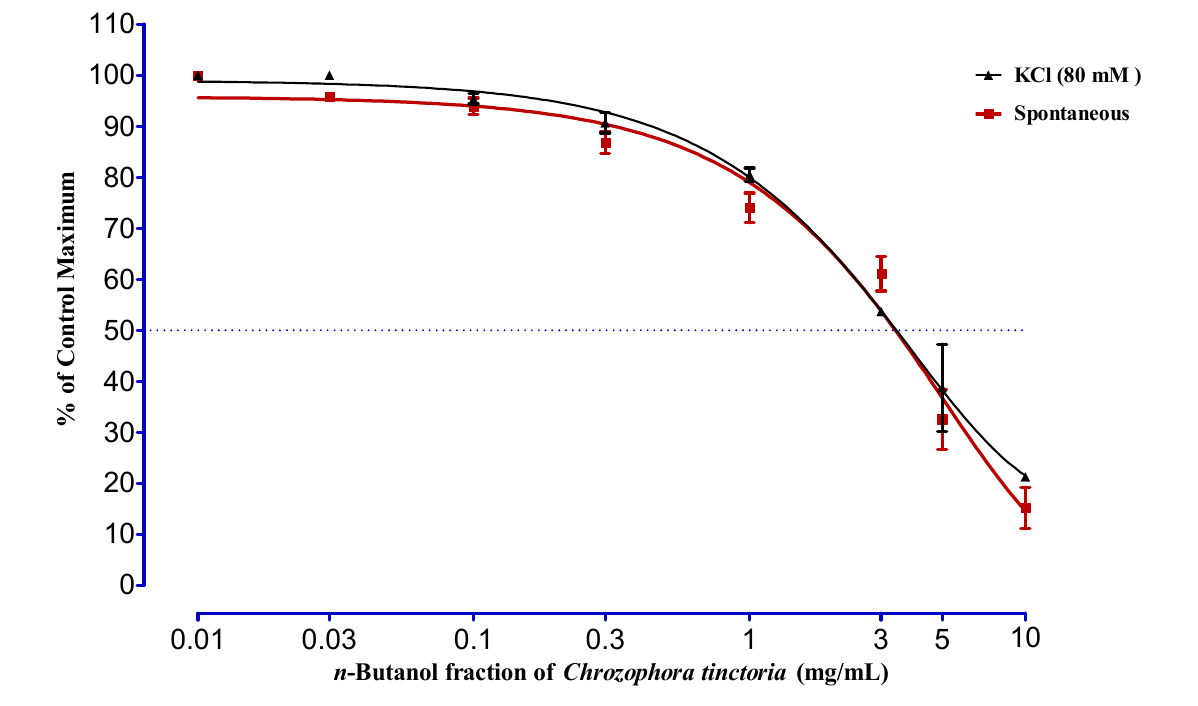
Figure 5. The effect of NBFC on spontaneous and KCl-induced (80 mM) contraction of rabbit jejunum. Rabbit jejunum muscle was relaxed in a dose-dependent manner. EC 50 values were calculated from curve fitting in GraphPad Prism 6.01. Each point represents the mean ± SEM of grouped